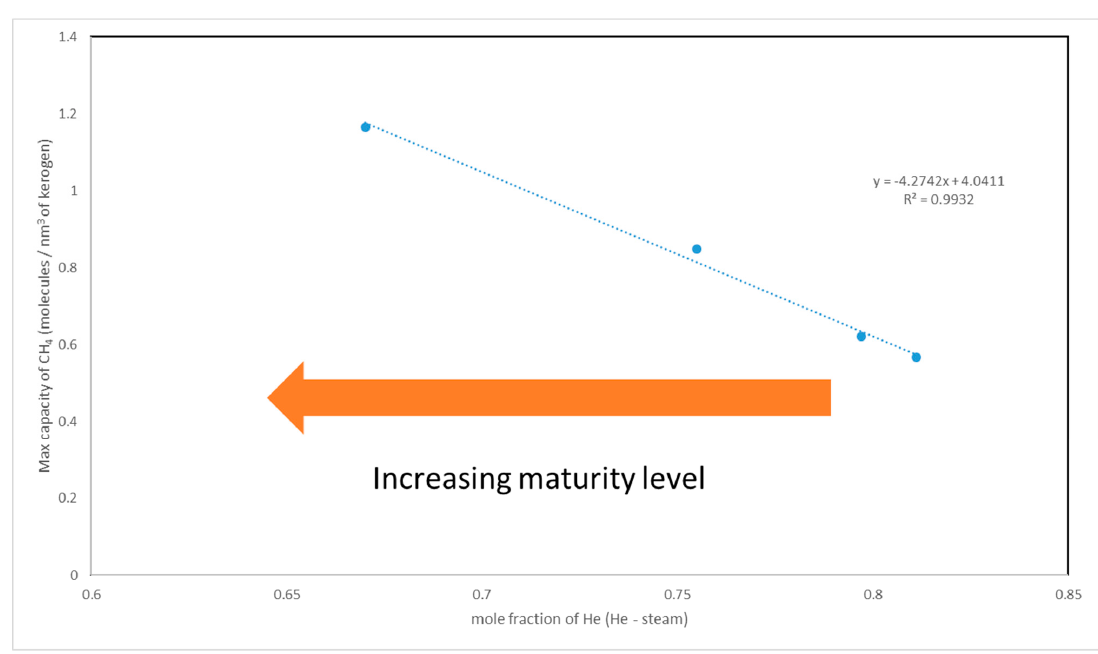
Figure 7. Maximum adsorption capacity and numeric scale of maturity. A linear correlation appears between the He capacity (taken to reflect maturity) and CH 4 storage capacity.